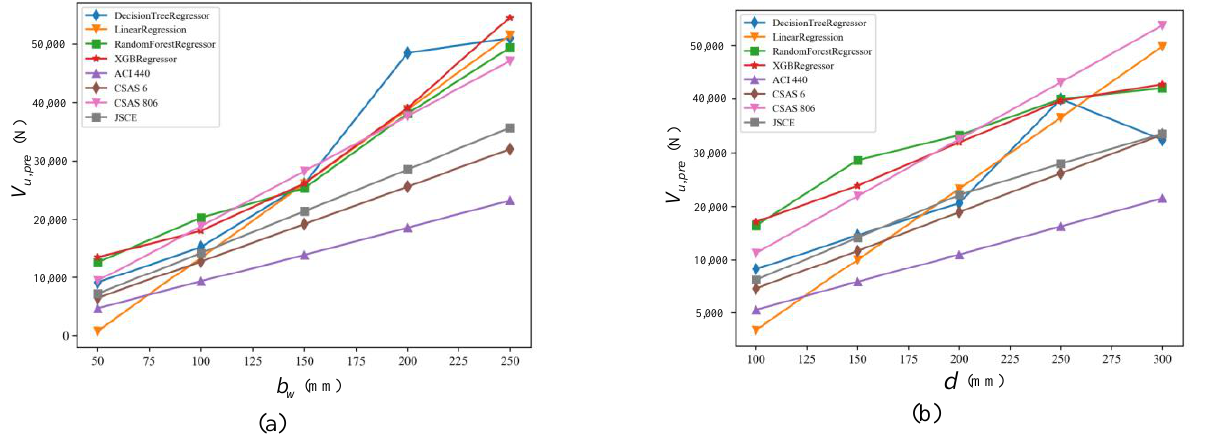
Figure 11. Effects of web breadth ( a ) and effective depth ( b ) on shear performance.